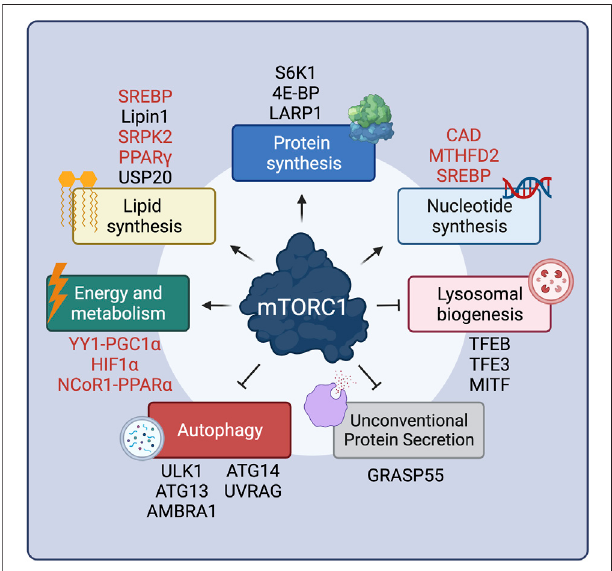
FIGURE 1 | mTORC1 positively or negatively regulates multiple cellular functions via key effector proteins. Proteins that are regulated by mTORC1 only indirectly are shown in red. See text for details. Created with